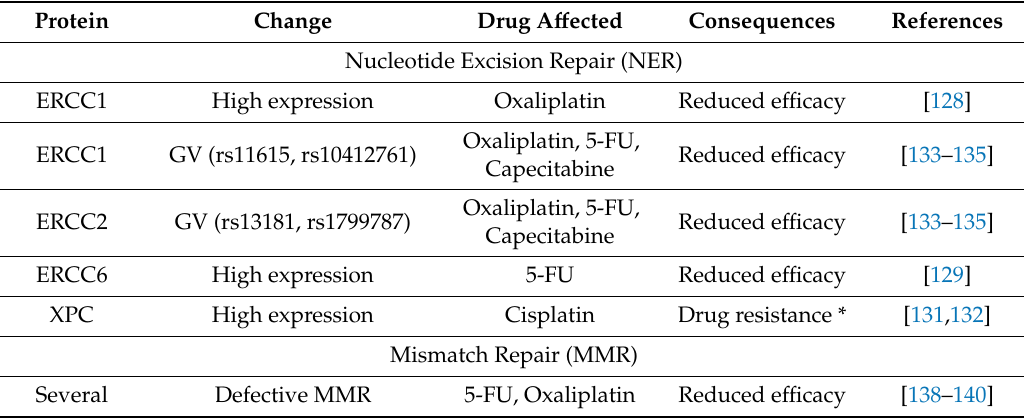
Table 4. Mechanisms of chemoresistance type 4 (MOC-4) in colorectal